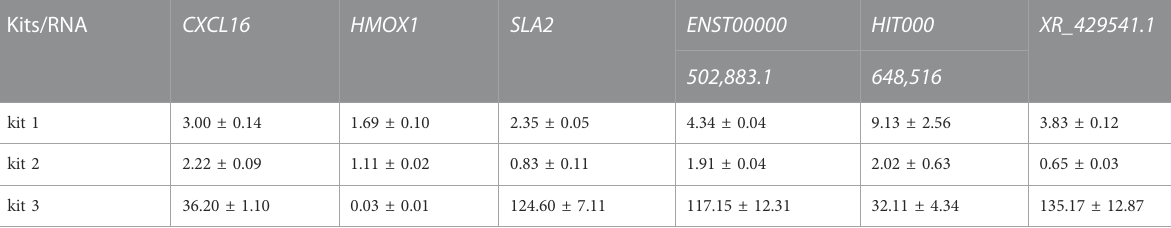
TABLE 3 The relative informative mRNA and lncRNA readouts in COPD in each group.